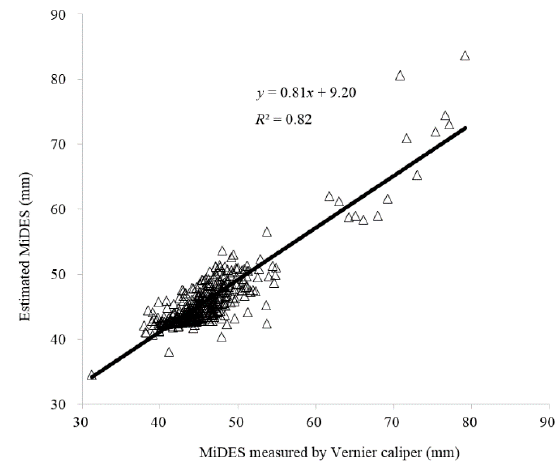
Figure 4. Comparison of MiDES between estimation and measurement by a Vernier caliper in the validation dataset.